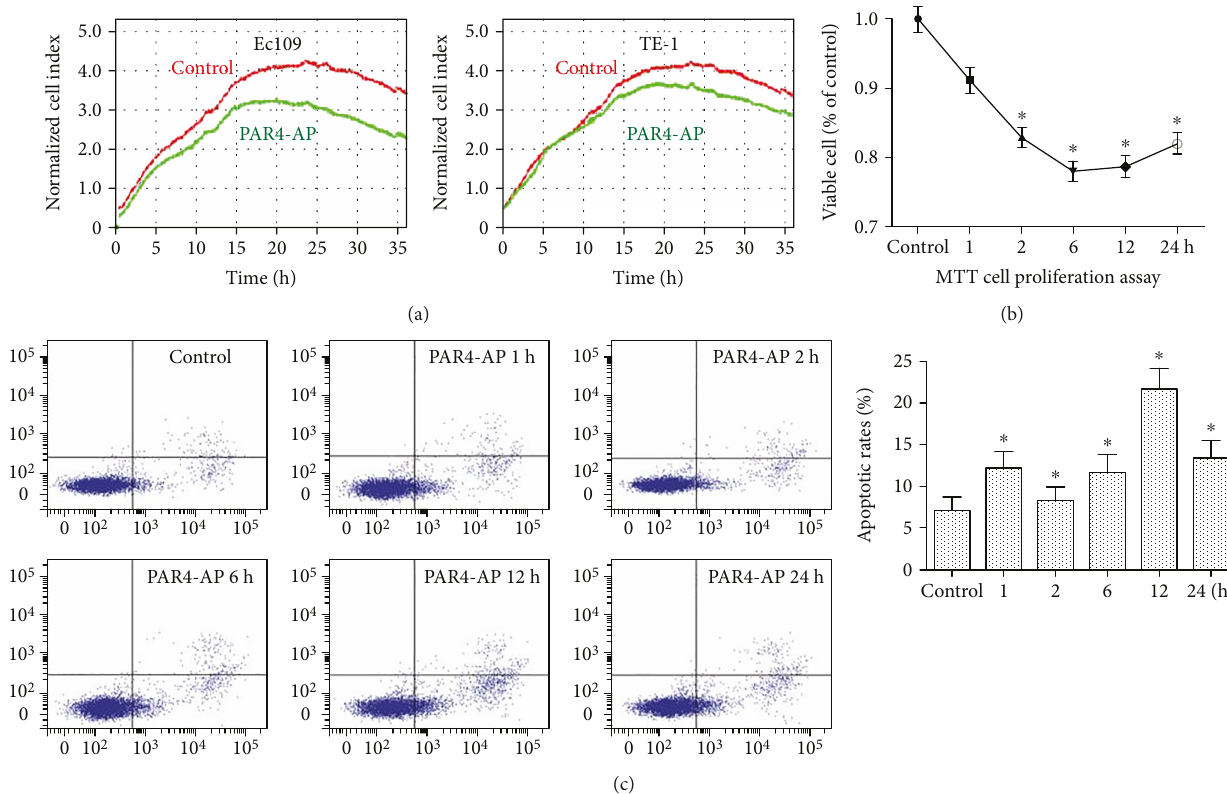
Figure 5: E ff ects of PAR4-AP on cell proliferation and apoptosis in ESCC cells. (a) RTCA was performed to evaluate the proliferation and viability of ESCC cells following continuous treatment with PAR4-AP. Green lines represent cell index (CI) treated with PAR4-AP, and red lines are CI treated with the PAR4 control peptide. (b) The cell viability of ESCC cells was measured by MTT assay following 1, 2, 6, 12, and 24h of treatment with PAR4-AP, respectively. (c) Cells were stained with Andy Fluor 488 Annexin V and PI and analyzed by fl ow cytometry following treatment with PAR4-AP. The ratio of apoptosis in ESCC cells was detected by fl ow cytometry following 1, 2, 6, 12, and 24h of treatment with PAR4-AP, respectively. The data are expressed as the mean ± SEM ( n = 3 ). ∗ P < 0 05 versus